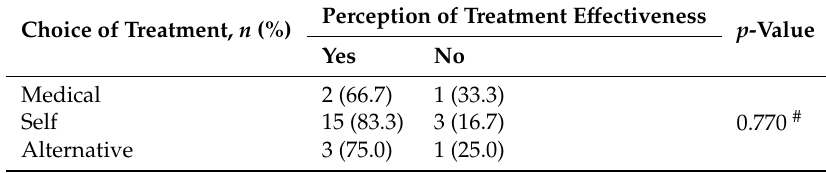
Table 3. The type of treatment taken and the e ff ectiveness of the treatment according to patients’ perception ( n =